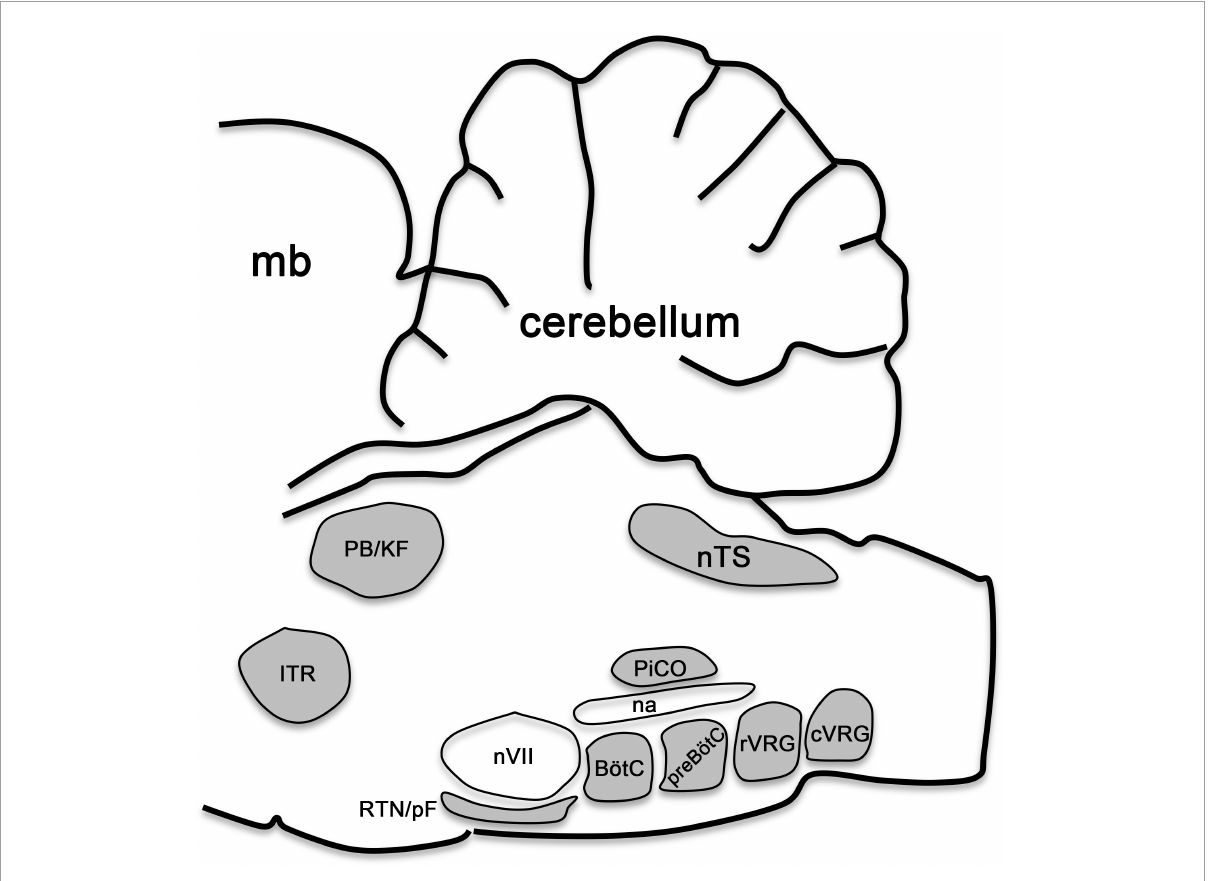
FIGURE4 Brainstem respiratory groups. Scheme representing the sagittal view of a mouse brainstem. This scheme illustrates the location of respiratory neurons belonging to the intertrigeminal region (ITR), parabrachial/Kölliker-Fuse complex (PB/KF), nucleus tractus solitarius (nTS), retrotrapezoid/parafacial nucleus (RTN/pF), Bötzinger complex (BötC), preBötzinger complex (preBötC), postInspiratory COmplex (PiCO), rostral and caudal ventral respiratory groups (rVRG and cVRG). The cerebellum, midbrain (mb), as well as the facial (nVII) motor nucleus and the nucleus ambiguus (na) are illustrated for anatomical orientation. This figure is adapted from our previous publication Isik and Hernandez-Miranda (2022) in Handbook of Clinical Neurology, Chapter 5, entitled Early development of the breathing network, published by Elsevier Books. The license number 5392080585902 between Hernandez-Miranda, Charite Universitätsmedizin Berlin and Elsevier allows us the reuse of it in a